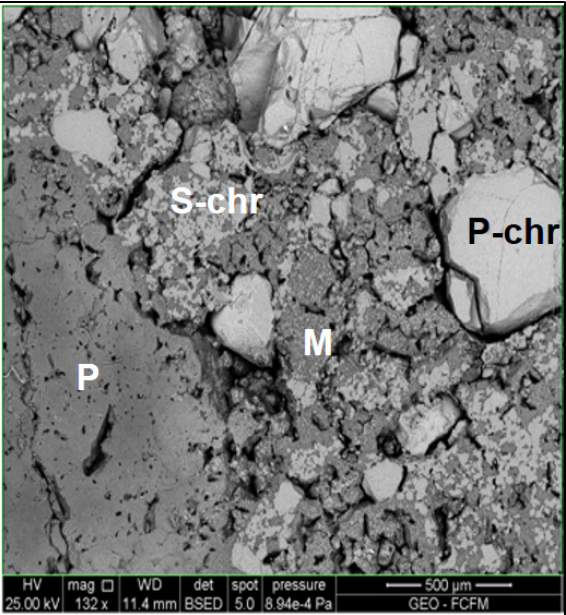
Figure 3. The presence of periclase grain (P), primary chromite (P-chr), a secondary chromite phase (S-chr), and a matrix phase (M) in the raw refractory brick determined by backscattered electrons (BSE) in SEM imaging.